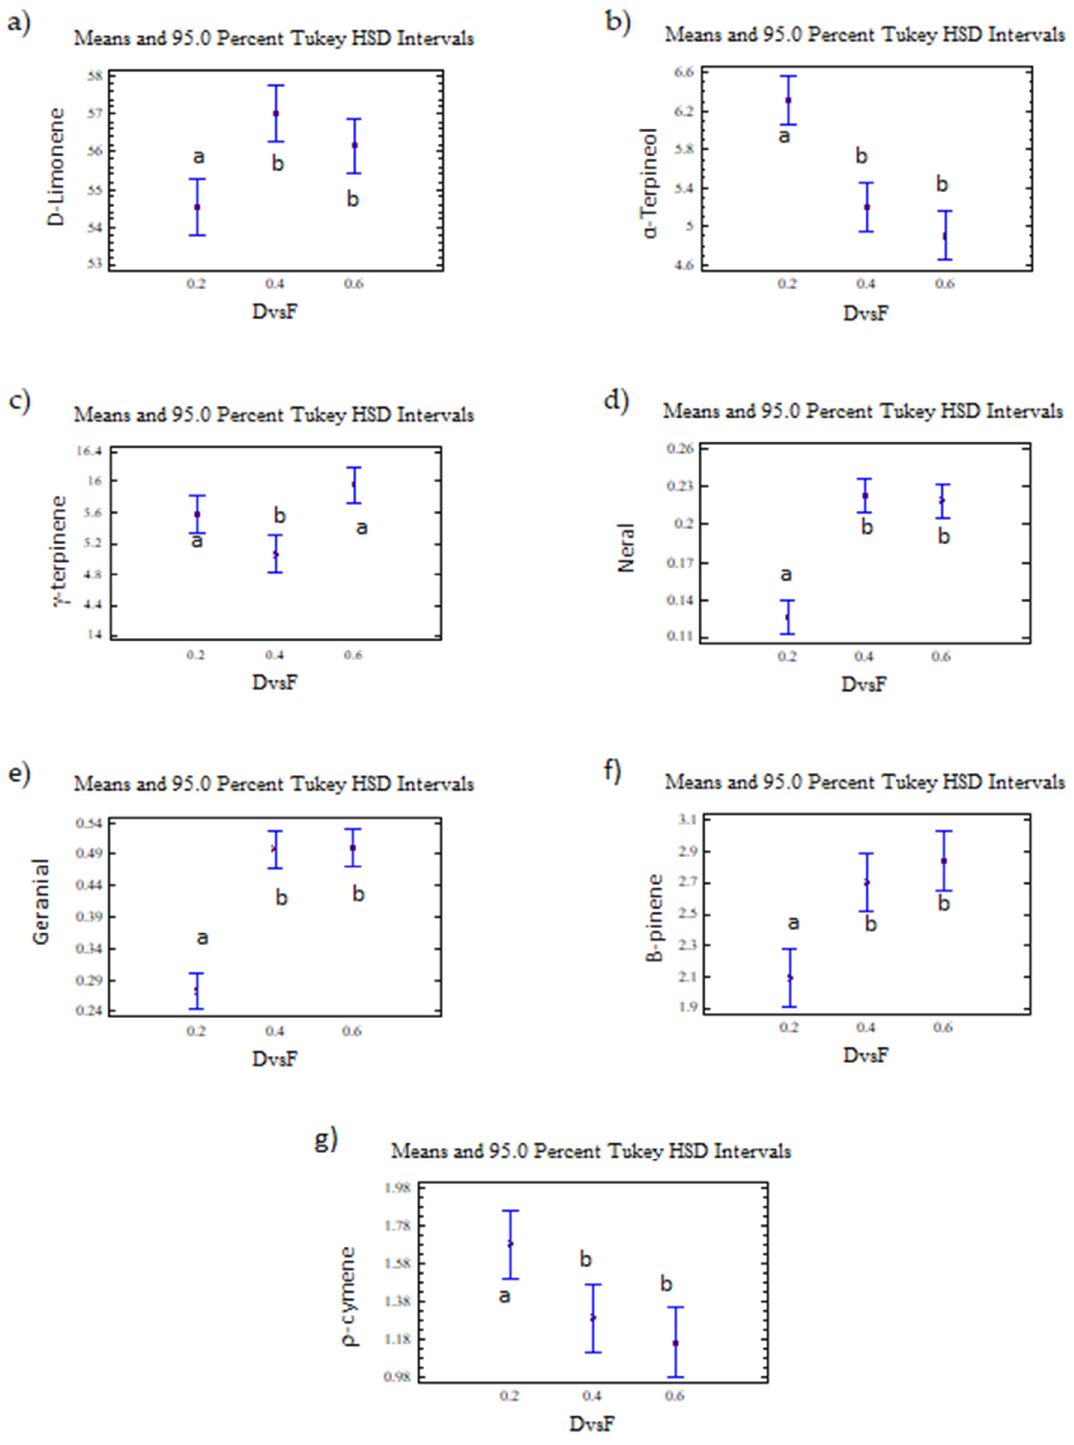
Figure 14. ( a ) d-limonene, ( b ) α -terpineol, ( c ) γ -terpinene, ( d ) neral, ( e ) geranial, ( f ) β -pinene, ( g ) p-cymene. The results are the average of three replicates ± standard deviation. Lowercase letters indicate homogenous groups. With 95% confidence, no statistically significant differences were found in the F1 frac- tions with respect to the experimental runs carried out in batch distillation (Table 5).